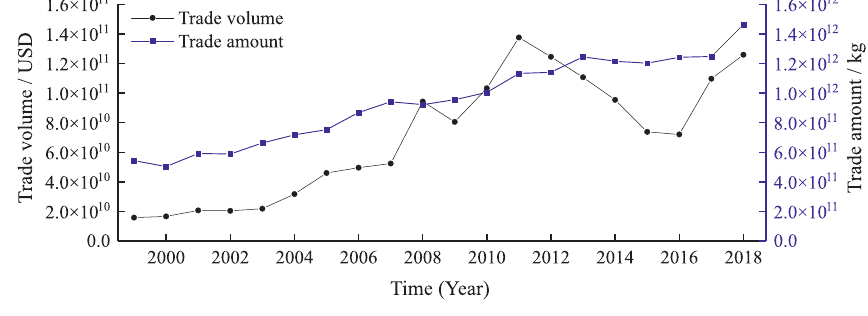
Figure 2. Changes in the coal trade from 1999 to 2018